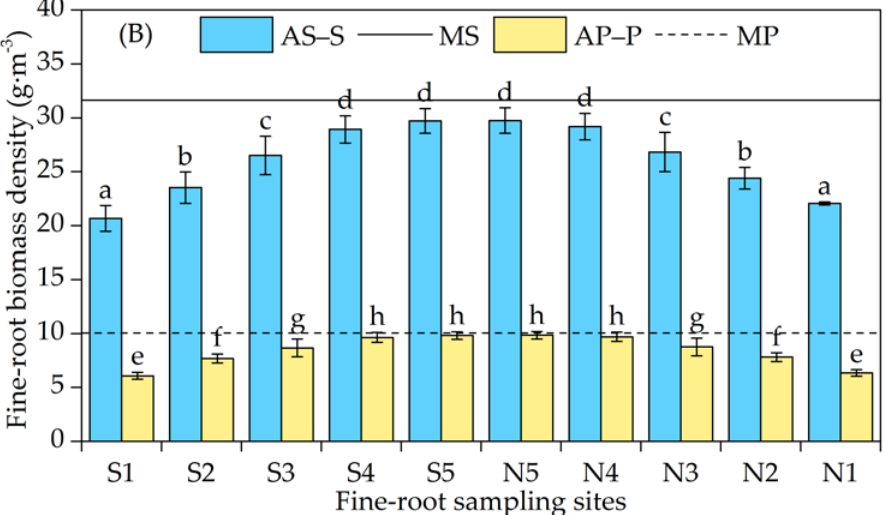
Figure 3. Horizontal distribution of the fine-root biomass density (FRBD) of ( A ) monocropped apple trees (MA), intercropped apple trees in apple–peanut intercropping systems (AP–A), and intercropped apple trees in apple–soybean intercropping systems (AS–A); ( B ) monocropped soybean plants (MS), intercropped soybean plants in apple–soybean intercropping systems (AS–S), monocropped peanut plants (MP) and intercropped peanut plants in apple–peanut intercropping systems (AP–P). The FRBD of each section was the mean value of FRBD of the 0–100 cm depth. The error bars indicate standard deviations. The means with different letters within a row or column are significantly different ( P <0.05).